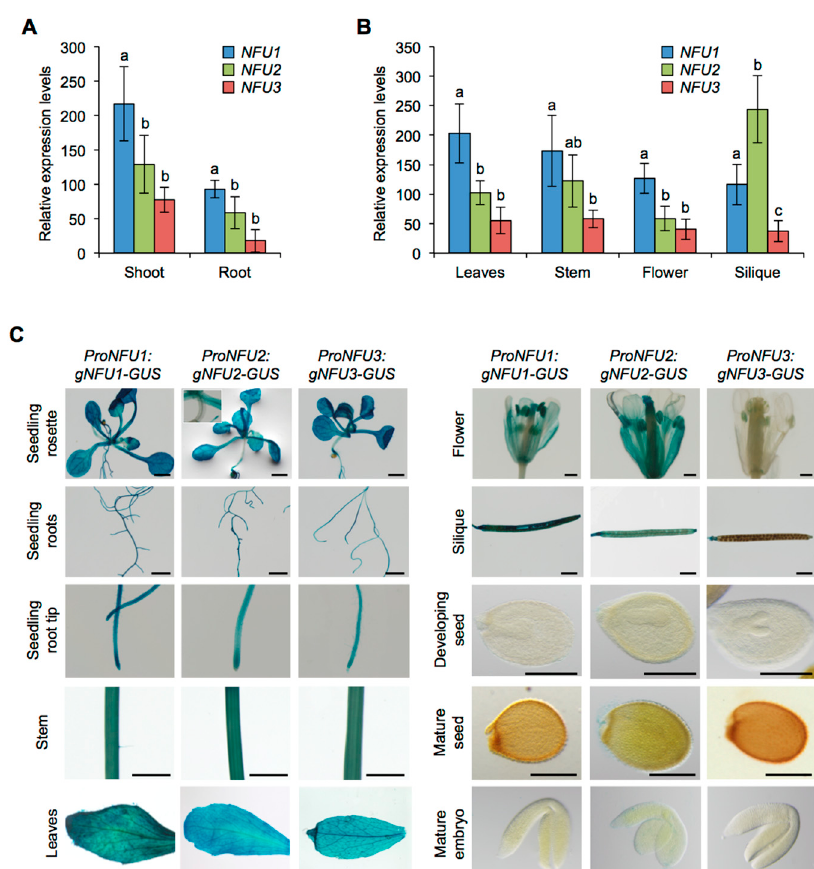
Figure 1. Analysis of NFU1 , NFU2, and NFU3 gene expression and protein localization in Arabidopsis thaliana . Analysis of NFU1 , NFU2, and NFU3 gene expression in roots and shoots of 7-day-old wild type Arabidopsis seedlings ( A ) and in leaves, stems, flowers and siliques of 4-week-old plants ( B ) by qRT-PCR. ( A , B ) Means within each condition with the same letter are not significantly different according to one-way ANOVA followed by post hoc Tukey test, p < 0.05 ( n = 6 technical repeats from three biological replicates from one representative experiment). Error bars show the means ± SD. ( C ) NFU1, NFU2, and NFU3 protein localization revealed by GUS activity in 7-day-old seedlings and in leaves, stem, flowers, siliques, seeds, and embryos of 4-week-old plants. Bars: seedling aerial parts and roots, stems = 0.5 cm; root tips, leaves, flowers and siliques = 0.1 cm; seeds and embryos = 0.05 cm.